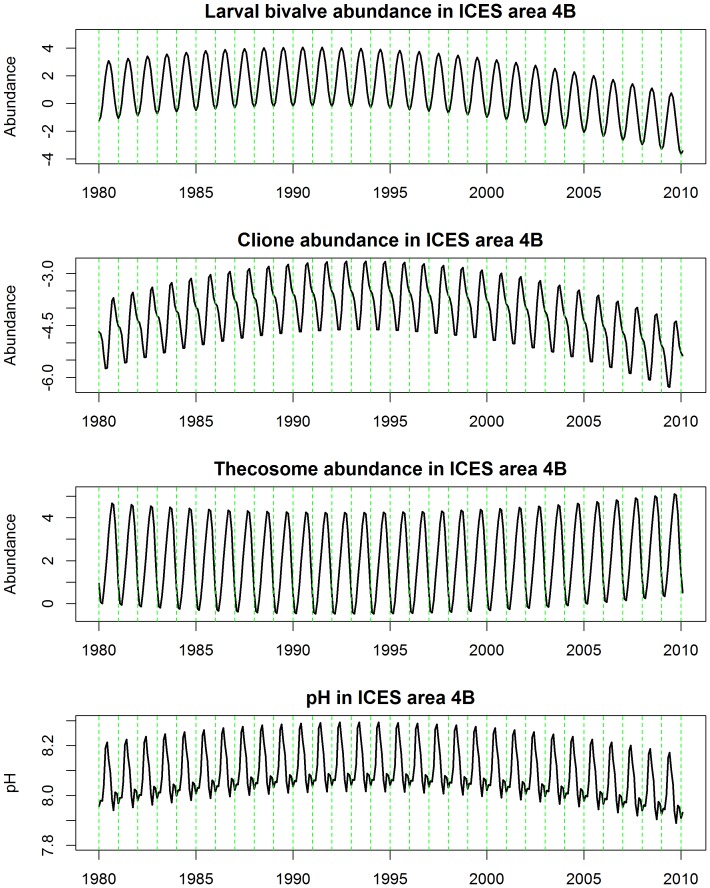
Predicted values from the harmonic seasonal regression models fitted to bivalves, Clione, thecosomes and pH (ie. output from models 1,2,3 & 4).